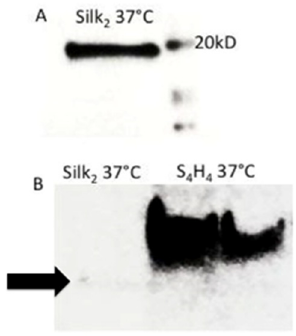
Figure 2. Western blots for ( A ) SX2 protein and ( B ) S4H4 (2 clones) using a HRP-conjugated anti-His antibody. Molecular weight markers are shown on SX2. Note that all gels were non-reducing.